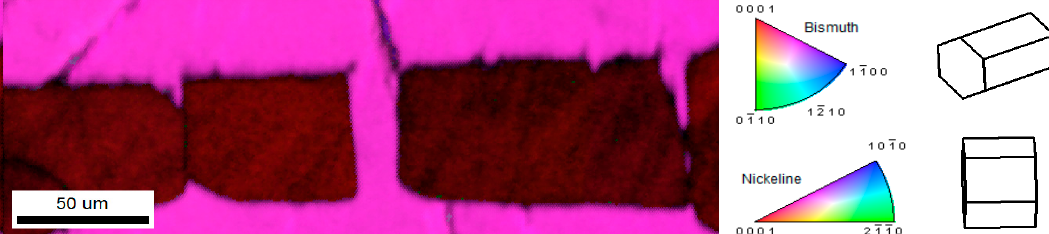
Figure 4. Representative electron backscatter diffraction (EBSD) inverse pole figure (IPF) [010] map (colorized legend to the right of image) overlayed on a greyscale image quality map of the magnetically annealed 20 at.% MnBi sample. The darker red rectangle features are MnBi, which adopts the hexagonal nickeline structure. The consistent red color of the grains indicates they are all almost perfectly oriented with their c-axis along the left–right A2 axis. The c-axis of the surrounding Bi grain in which they are embedded is oriented at approximately 24 ◦ relative to the A2 axis, with the surface normal plane being